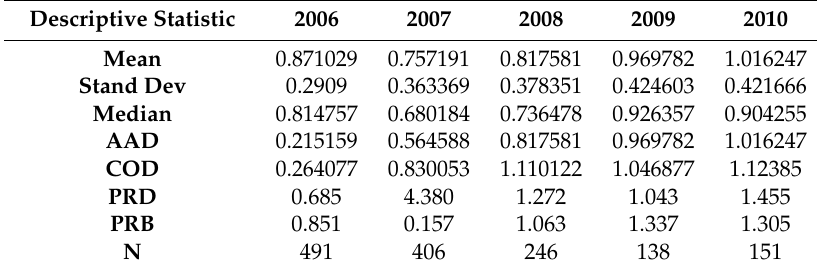
Table 5. Land ratios descriptive statistics for all qualified sales in